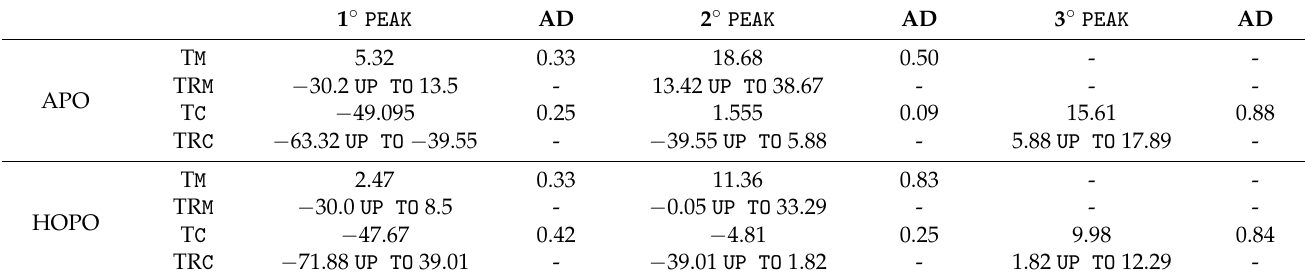
Table 3. Thermal events APO and HOPO obtained from the differential scanning calorimetry (DSC) curves.